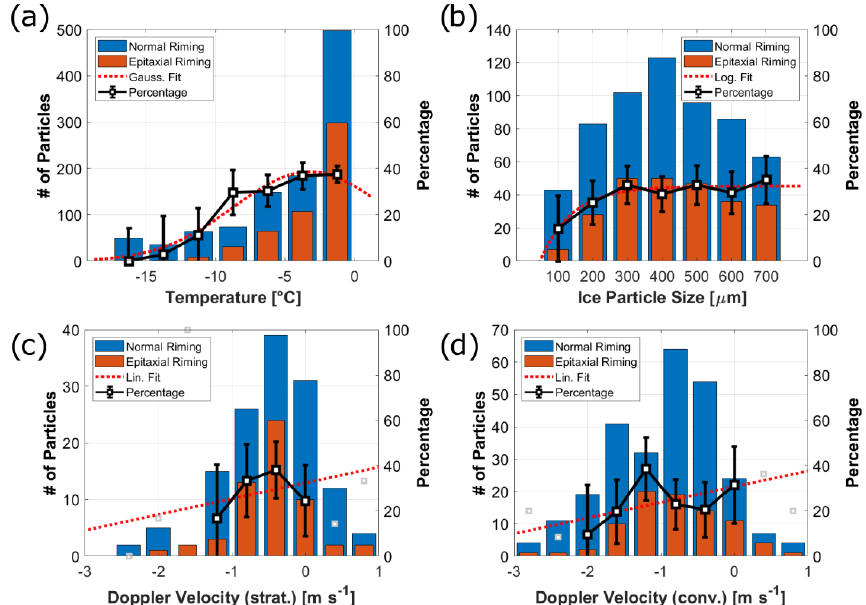
Figure 9. Absolute number of analyzed particles for normal (blue) and epitaxial (red) riming and fraction of epitaxially rimed particles as a function of ambient temperature (a) , ice particle size (b) and HCR Doppler velocity for stratiform (c) and convective cloud segments (d) . Only bins with more than n ≥ 20 data points were taken into account ( n < 20 are shown in